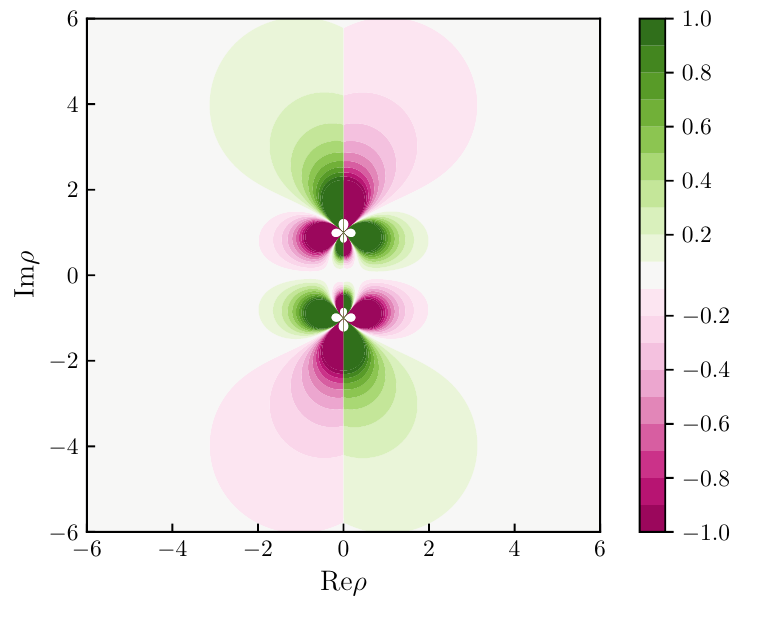
n(cid:0) (cid:3)o (cid:1) − 2 (cid:2) (cid:0) (cid:1) , to show branch cuts (on the ρ 2 + m 2 ρ 2 ln ρ 2 /m 2 − ρ 2 − m 2